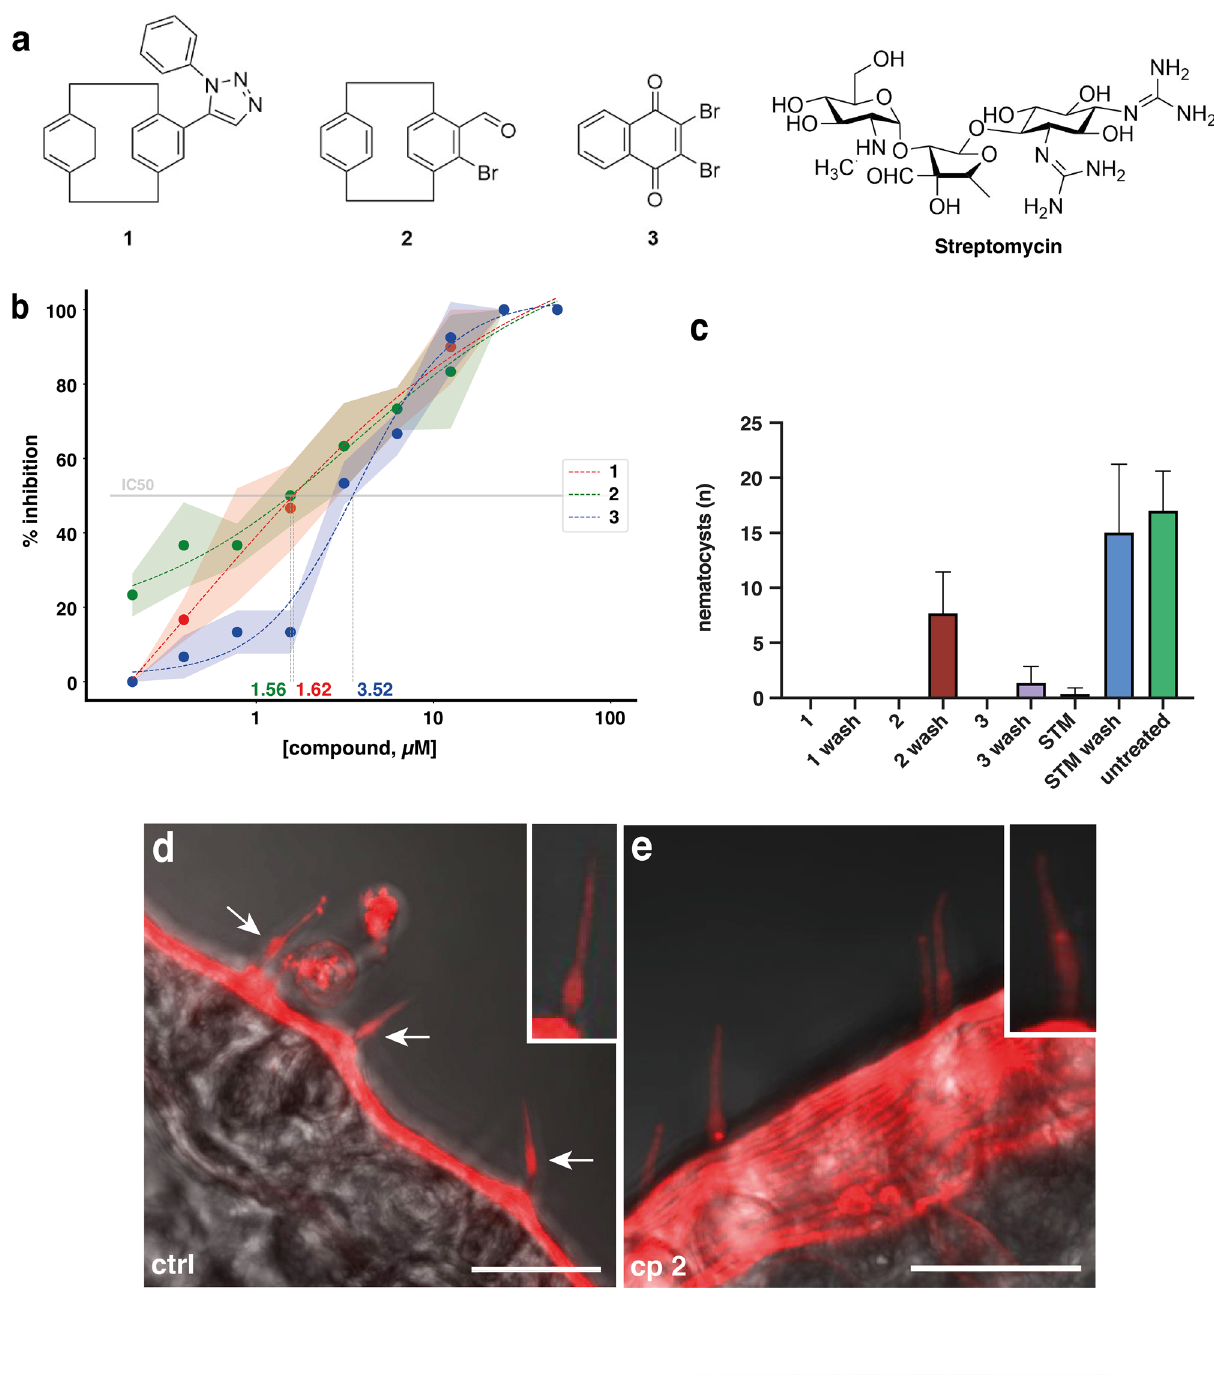
Figure 3. Detailed analysis of nematocyst discharge inhibition for three candidate molecules. ( a ) Structures of compounds 1 , 2, and 3 . ( b ) Prey capture inhibition at different concentrations of selected small molecules. Animals were treated in triplicates with the indicated concentration of the compounds for 30 min. Nematocyst discharge was recorded by counting the fraction of artemia (out of ten) caught by each polyp. The inhibitor concentration is shown on the log scale. Colored areas correspond to standard deviation. IC50 values were determined by fitting sigmoid curves to the average inhibition (dashed lines) and solving them for 50% inhibition. ( c ) Reversibility assay of mechanosensitive nematocyst discharge was tested by recording discharge in the presence of each selected compound at 12.5 µM and again immediately after compound removal (wash). Nematocyst discharge was evaluated by counting the number of attached stenoteles after mechanical stimulus with a gelatin-covered fishing line. Error bars represent standard deviations from triplicate experiments. STM, Streptomycin. ( d ) Immunostaining of Hydra whole-mounts with a pan-TRPN antibody shows a prominent signal at the base of cnidocils (white arrows) extending from battery cells of the tentacle surface. Control animals were treated with DMSO. ( e ) Treatment with compound 2 for 2 h leads to a loss of the signal probably due to the relocalization of TRPN in the battery cells. Scale bars = 10 µm. The insets show exemplary cnidocils at higher magnification. Images were acquired with a Nikon A1 confocal microscope using imaging software NIS Elements (AR